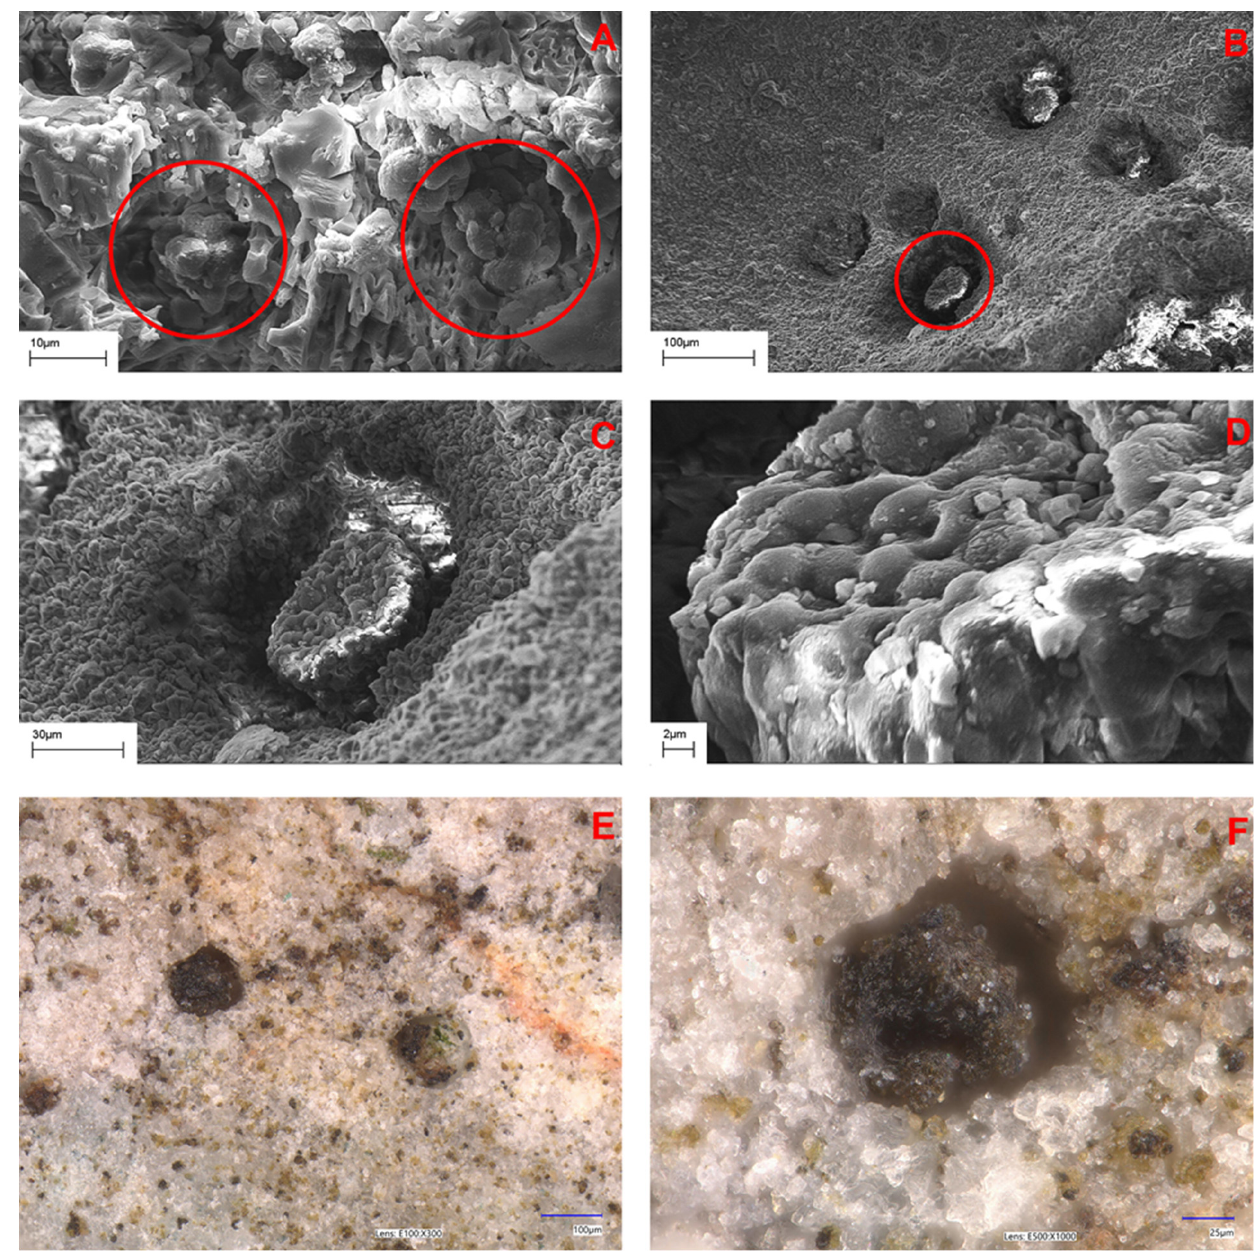
Figure 18. The influence of microorganisms on the weathering of limestone detected by SEM—clusters of yeast-like cells, site 2 ( A ), microcolonies of yeast-like cells, site 4 ( B ), microcolonies embedded in deep caverns, site 4 ( C – D ), samples from site 5 observed under Keyence Digital Microscope ( E , F ).